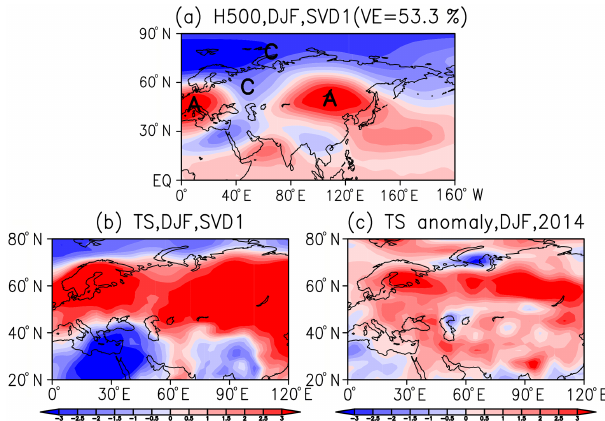
Figure 8. Heterogeneous correlation map of the first SVD mode for detrended and normalized (a) H 500 during DJF and (b) T s during DJF 1979–2014, as well as (c) the T s anomalies during DJF 2014. Letters A and C in panel (a) represent anticyclone and cyclone, re-